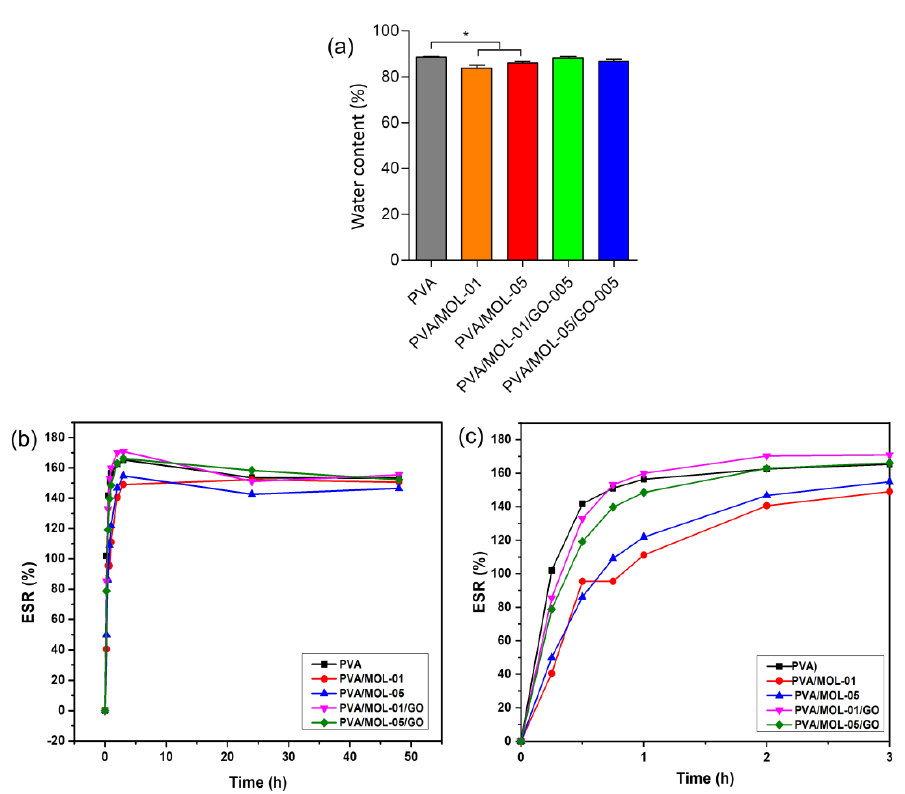
Figure 4. ( a ) Water content. ( b ) Swelling profile of all the hydrogels time vs. ESR at timepoint 0–48 h and ( c ) 0–3 h. Data represents means ± SD from at least three independent experiments. * p <